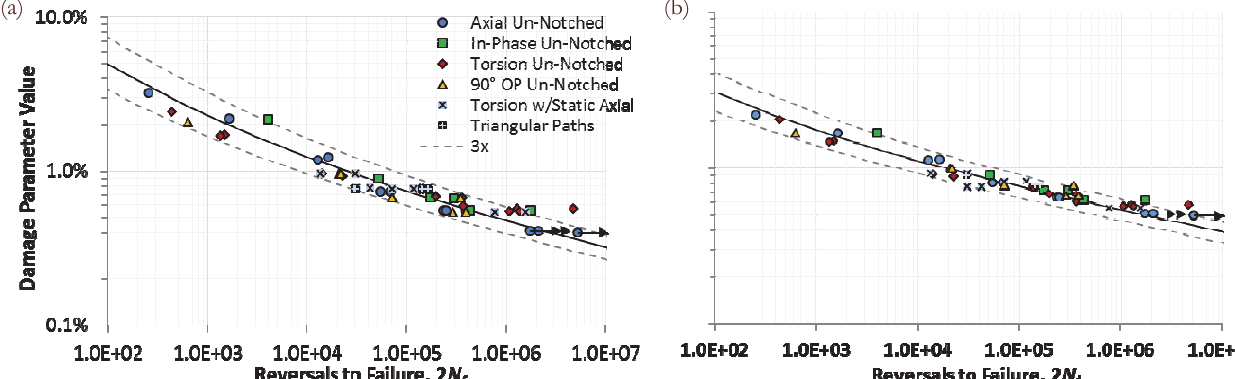
Figure 3: Fatigue life correlations for 2024-T3 aluminum alloy based on (a) FS and (b) modified FS parameters with uniaxial strain-life properties and k =